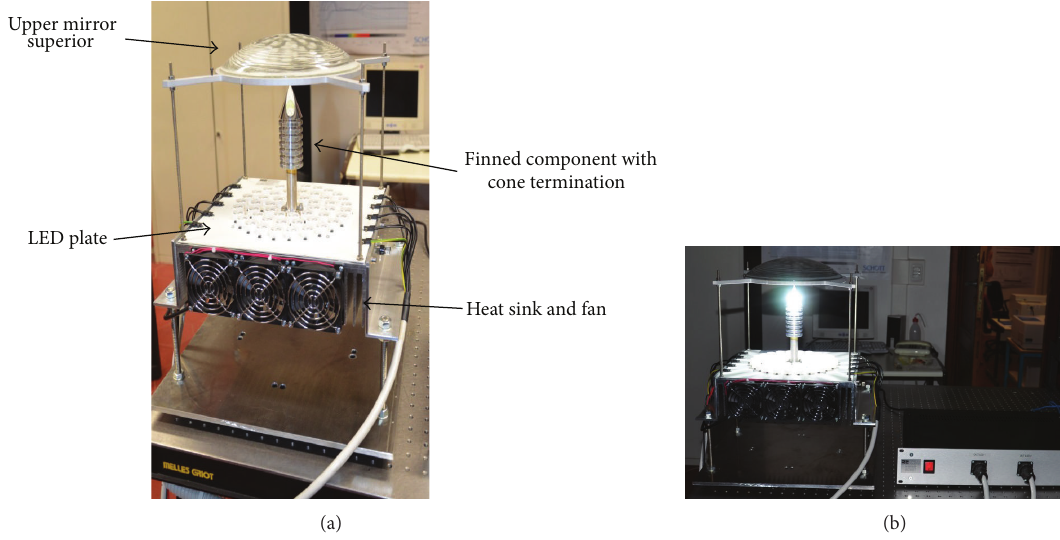
Figure 2: (a) Assembled LED-based lamp. (b) The LED lamp assembled and running.